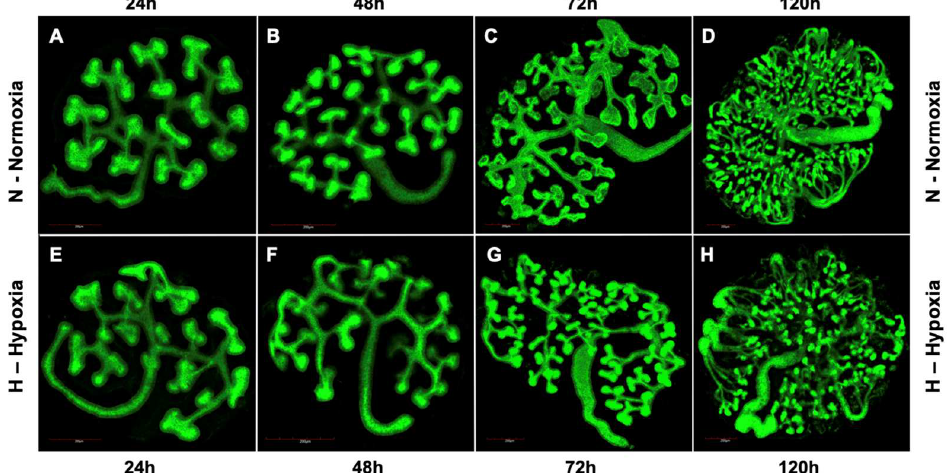
Figure 1. Kidney growth in normoxia and hypoxia. Embryonic kidneys exposed to hypoxic conditions during in vitro culture ( E – H ) exhibit different growth pattern compared to in vitro culture under normal conditions ( A – D ). Kidneys in hypoxic condition show increased branching from 24 h ( E ), but with a reduced overall and lower tip volume. Organs at 48, 72 and 120 h ( F – H ) present with stunted growth, reduced total volume and thinner collecting duct branches.